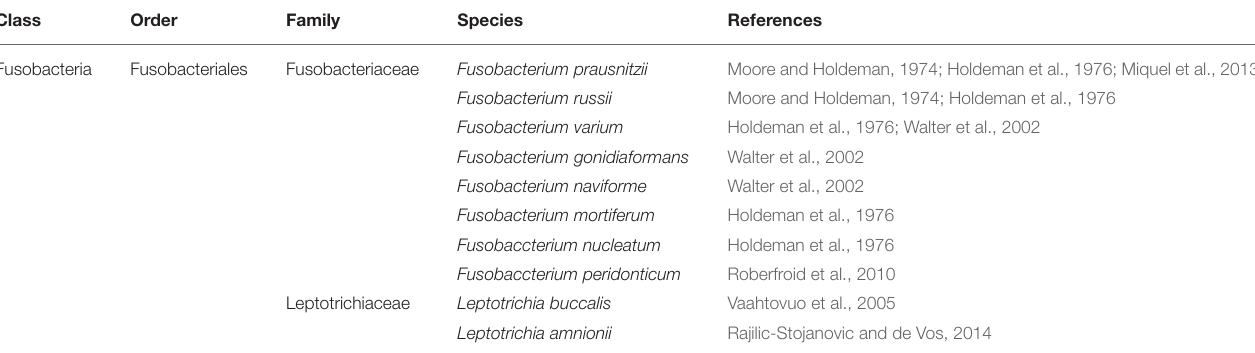
TABLE 5 | Fusobacteria phylum (class, order, family) and major species constituting the microbiota in healthy human gut.